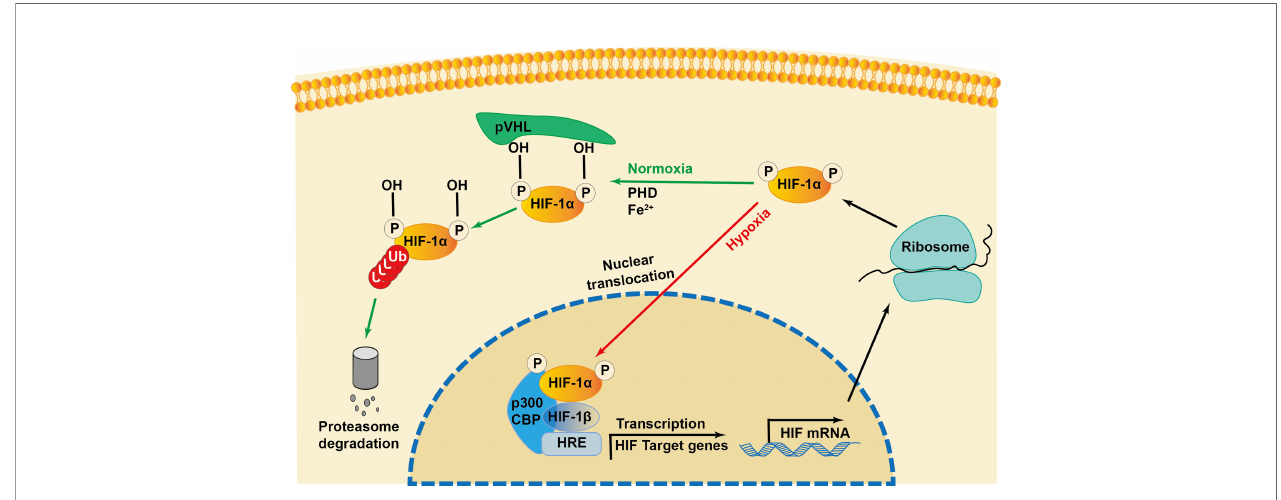
FIGURE 2 | Regulation of HIF-1 a during normoxia and hypoxia. Under normoxia, HIF-1 a hydroxylase (PHD) hydroxylates the proline in the presence of iron (Fe2+), which recruits the von Hippel-Lindau protein (pVHL) to bind and initiate the proteolysis of HIF-1 a by acting as a recognition component of ubiquitin ligase complex, leading to proteasomal degradation. Under hypoxia conditions, the interaction of transcriptional coactivators p300/CBP (CREB-binding protein) is activated. HIF-1 a is stabilized and translocated into the nucleus and heterodimerizes with constitutively expressed HIF-1 b , binds to the hypoxia responsive elements (HRE) and enhances the transcription of HIF-1 a target